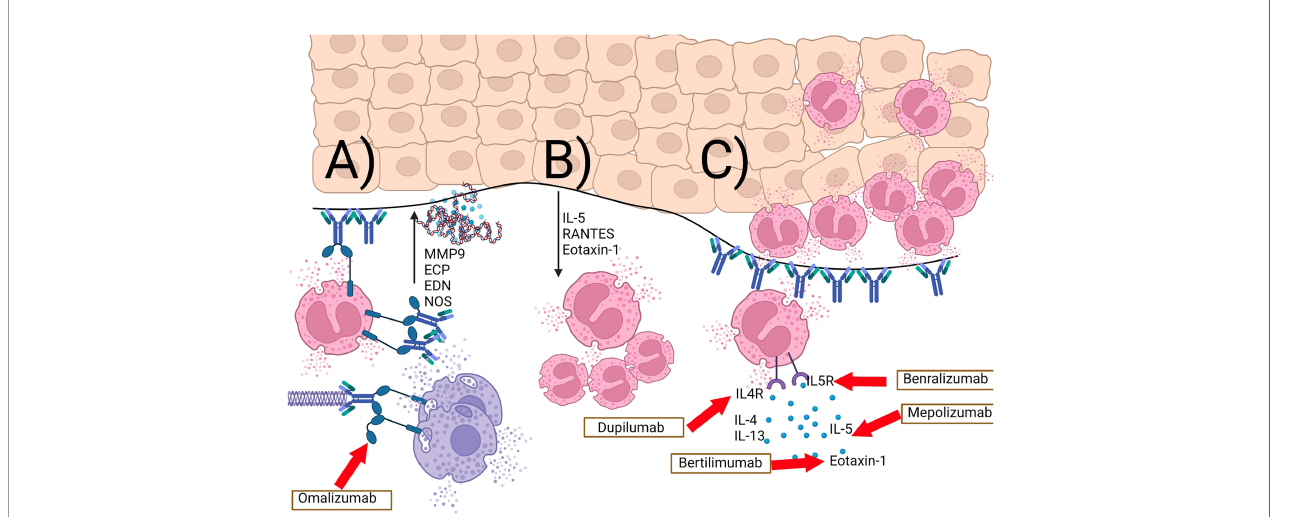
FIGURE 2 | IgE- and eosinophil-mediated complement-independent pathways in bullous pemphigoid. (A) BP180 IgE autoantibodies and BP180-IgE complexes bind to the cutaneous basement membrane and the Fc ϵ R1 on eosinophils as well as mast cells and basophils. This results in release of proteases (e.g. MMP9), eosinophil granule proteins (ECP, EDN), eosinophil extracellular traps, as well as reactive nitric oxide-derived oxidants (NOS). (B) Keratinocytes release IL-5, RANTES, and eotaxin-1 as a response to eosinophil granule proteins. (C) this positive feedback loop results in an increase in tissue eosinophilia and eosinophilic spongiosis. Inhibitory therapeutic antibodies are shown in boxes with red arrows leading to their downstream